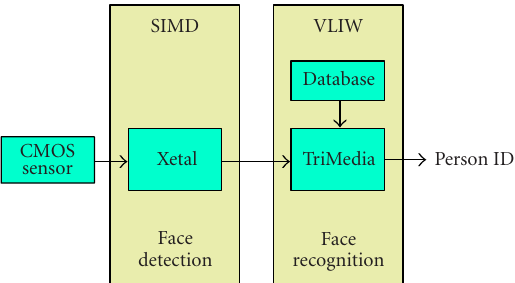
Figure 3: Face recognition actually has two parts, the detection and the recognition. The complete detection part is perfectly mapped to the SIMD processor doing the low-level operations. The recognition part is dealt with by the VLIW